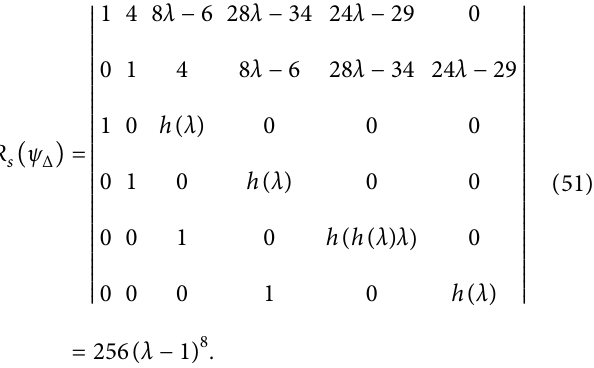
Figure 1: (a) Figure of function φ on the interval [ 0 , 1 ] ; (d) figure of function ψ